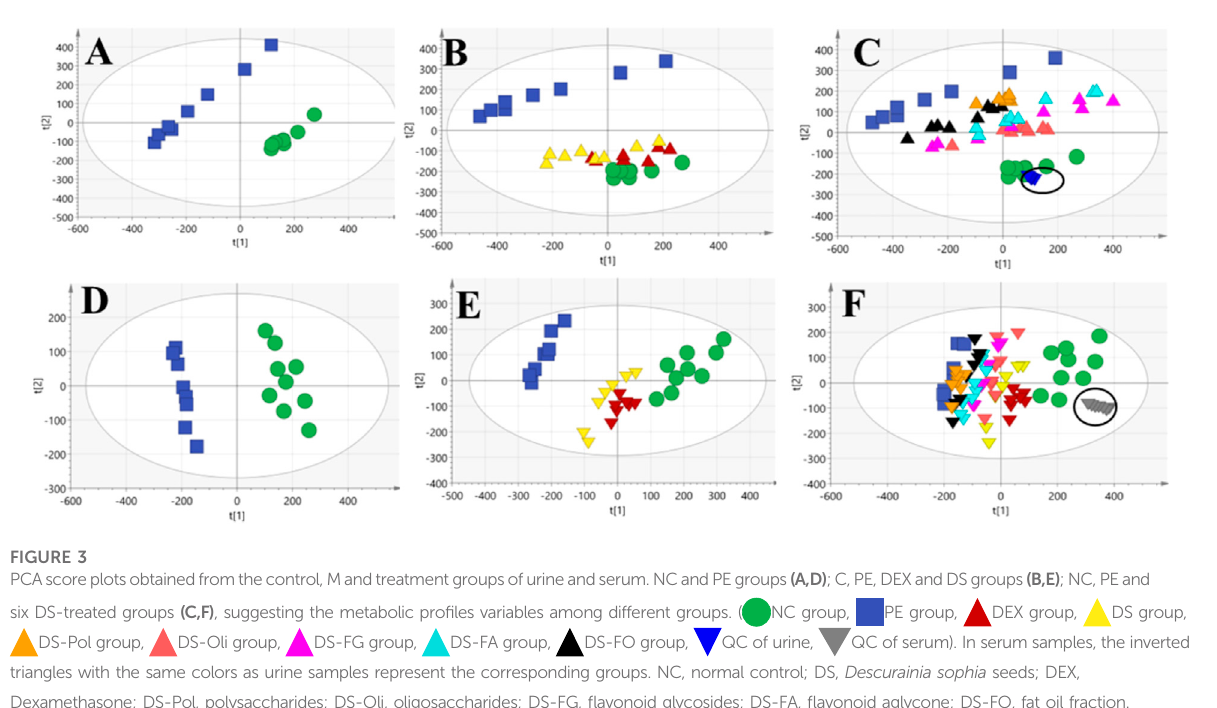
FIGURE 3 PCAscoreplotsobtainedfromthecontrol,Mandtreatmentgroupsofurineandserum.NCandPEgroups (A,D) ;C,PE,DEXandDSgroups (B,E) ;NC,PEand six DS-treated groups (C,F) , suggesting the metabolic pro fi les variables among different groups. ( NC group, PE group, DEX group, DS group, DS-Pol group, DS-Oli group, DS-FG group, DS-FA group, DS-FO group, QC of urine, QC of serum). In serum samples, the inverted triangles with the same colors as urine samples represent the corresponding groups. NC, normal control; DS, Descurainia sophia seeds; DEX, Dexamethasone; DS-Pol, polysaccharides; DS-Oli, oligosaccharides; DS-FG, fl avonoid glycosides; DS-FA, fl avonoid aglycone; DS-FO, fat oil fraction.